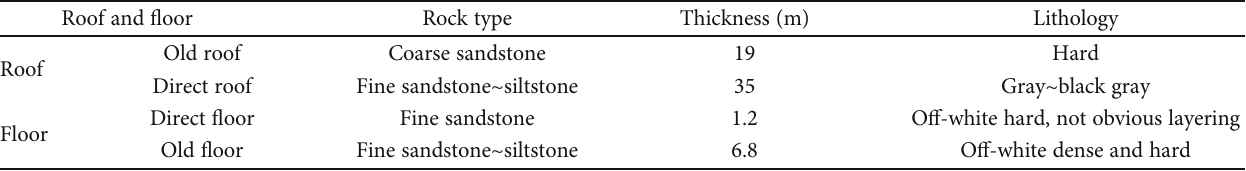
Figure 4: Statistics of shipment volume of working face impact. Table 5: Three-level 65-story roof and fl oor